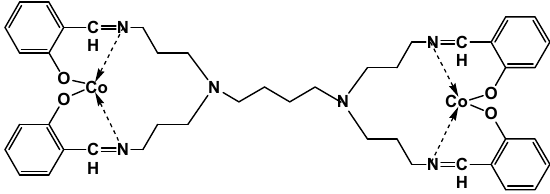
Figure 1 . First-generation cobalt(II) salicylaldiimine metallodendrimer (SDD–Co(II)). Figure 1. First-generation cobalt(II) salicylaldiimine metallodendrimer